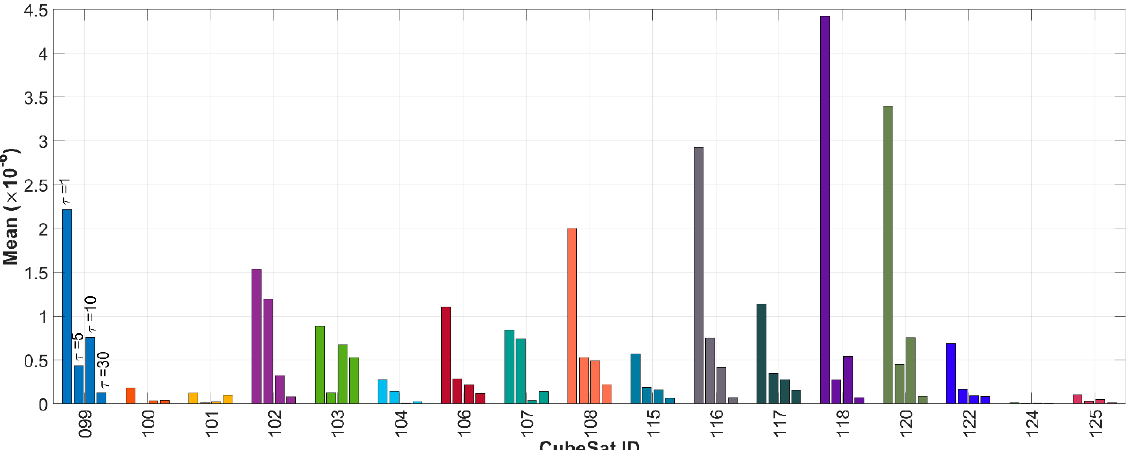
Figure 9. Mean of the MDEV reductions in the short-term stabilities after applying the proposed corrections compared to the first estimation of clocks, i.e., before applying the proposed remedies. Each CubeSat has four bars related to short averaging times (1, 5, 10, and 30 s, respectively). They are tagged for CubeSat 099 as an example.